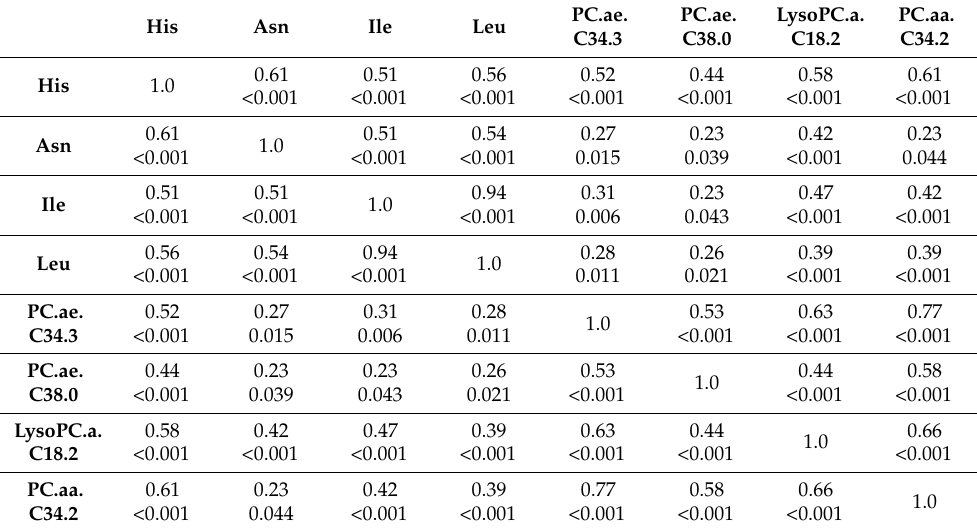
Table 3. Correlation matrix of metabolites of AAA patients (with r- and p -values).